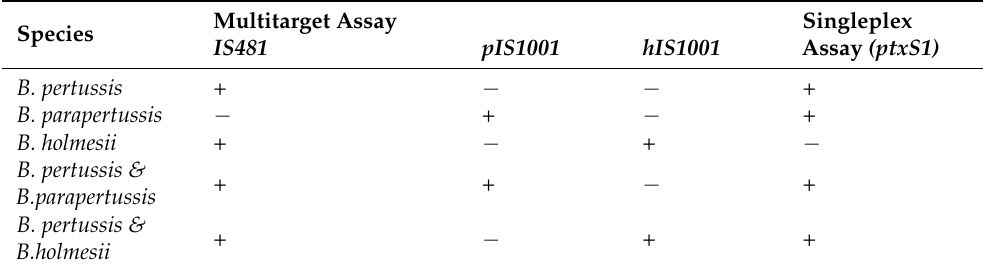
Table 1. Diagnostic algorithm for the detection and differentiation of Bordetella spp. [11]. Multitarget Assay Singleplex Species